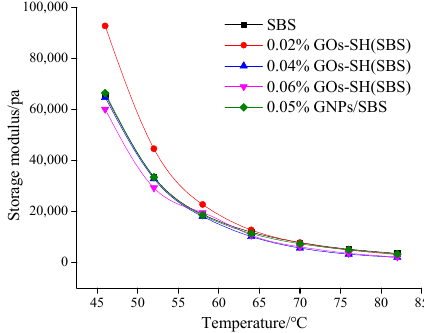
Figure 4. Effect of GOs-SH content on G’ as a function of temperature at 10 Hz.